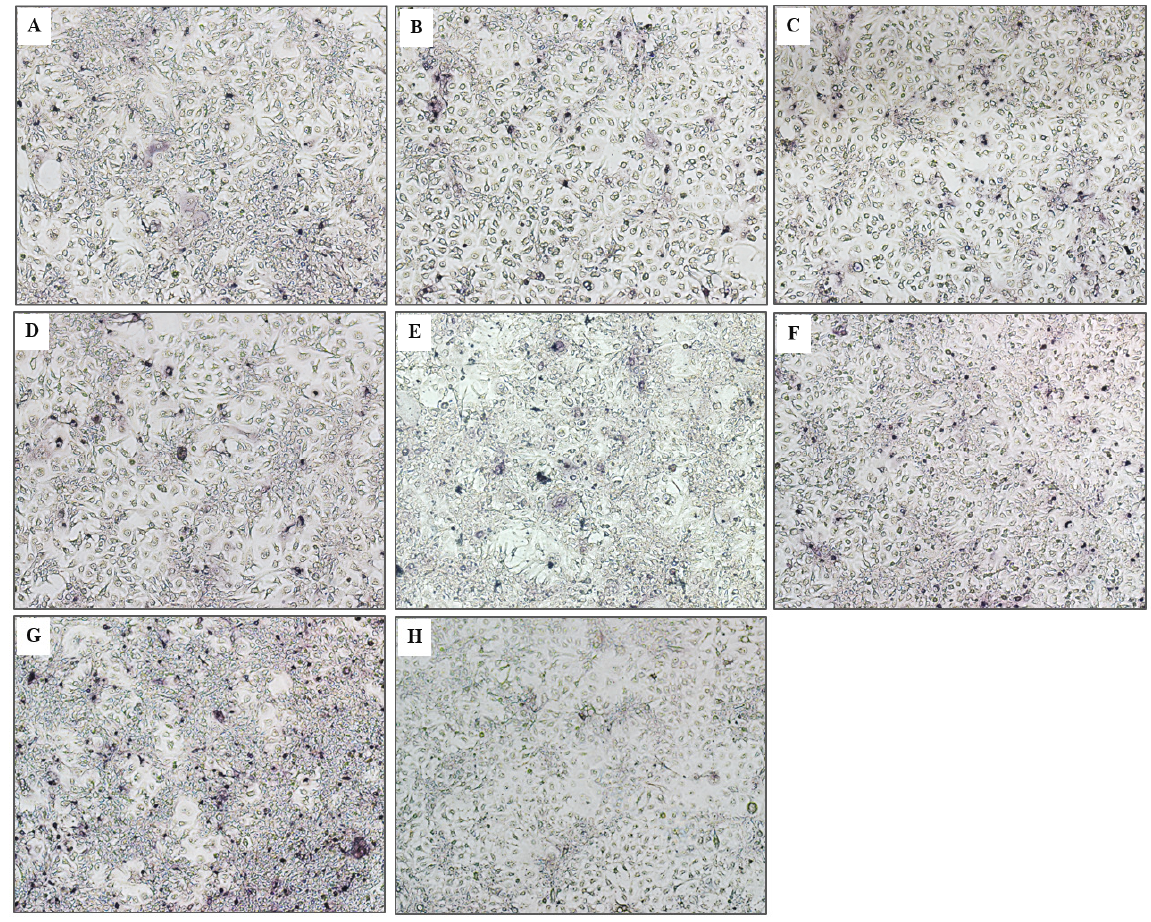
Figure 7. HCV foci in Huh 7 cells treated with cell penetrable V H Hs and controls.